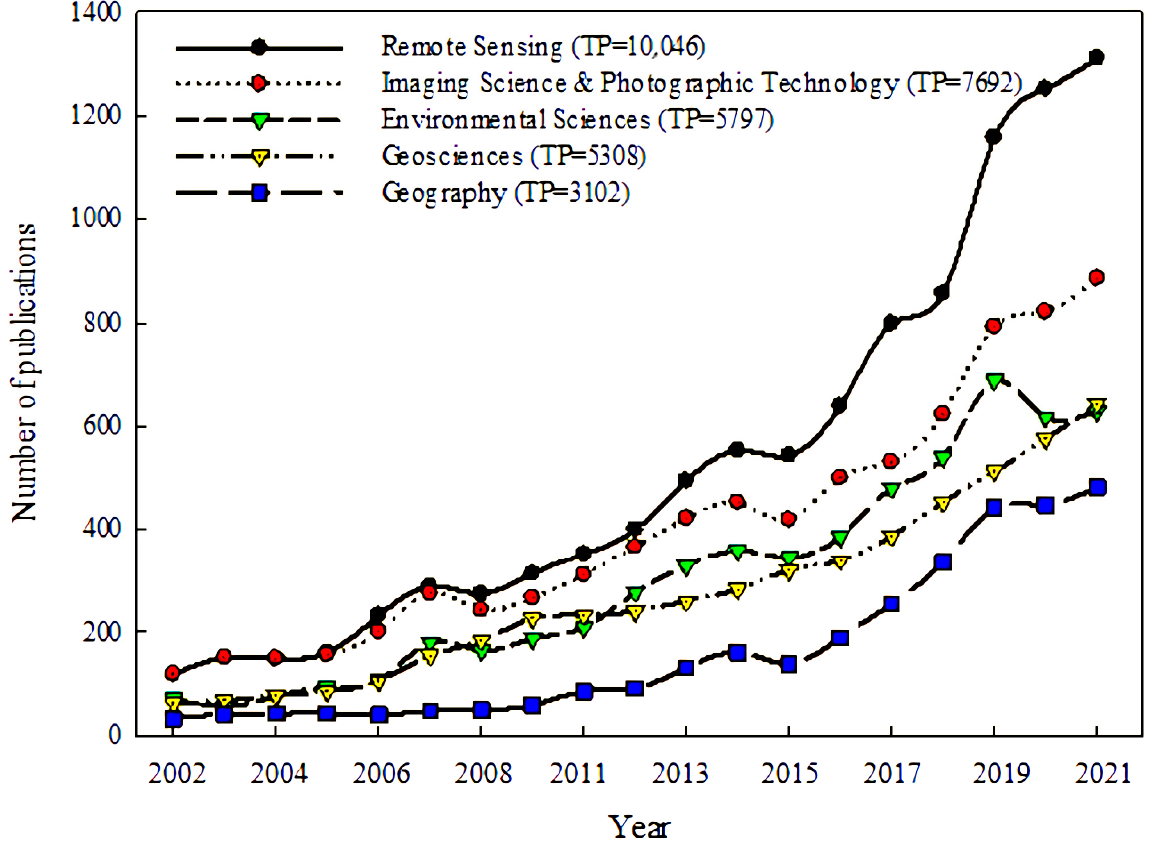
Figure 3. The top five subject categories. TP: The total number of publications.